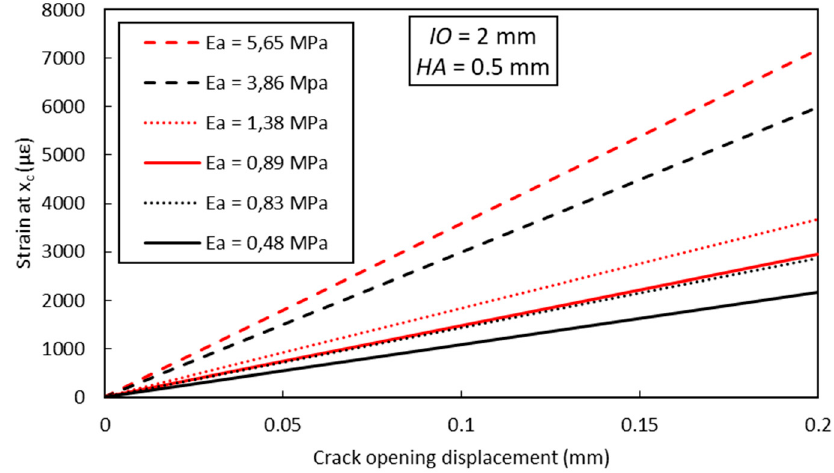
Figure 18. FEM calculation of the peak strain value versus crack opening displacement for different values of the adhesive elastic modulus.